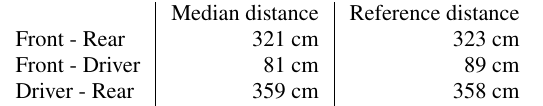
Table 4: Median and reference distances between the vehicle camera positions. Median is obtained from the calculated dis- tances for all time points using the estimated camera positions. The reference distances are obtained from tachymeter measure-